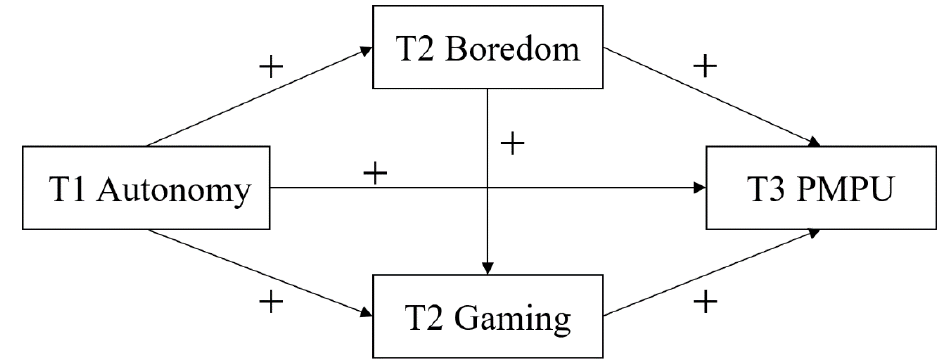
Figure 1. The conceptual model between autonomy need dissatisfaction and PMPU. Note. T1 Autonomy = Autonomy need dissatisfaction in Time 1; T2 Boredom = Boredom proneness in Time 2; T2 Gaming = Mobile phone gaming in Time 2; T3 PMPU = Problematic mobile phone use in Time 3.